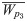
Cross Domain Diversity Weighting (Before/After).The cross domain diversity weight (DW) for the edge between predicate P3 and predicate P4 is computed as 0.35 using Eq (1). SW(P3, P4) = 0.2 and Wp3¯ = 0.2+0.5+0.83 = 0.5 and Wp3¯ = 0.2+0.2+0.33 = 0.23. DW(P3, P4) = Max(SW(P3,P4)+Wp3¯2,SW(P3,P4)+Wp4¯2) = Max(0.2+0.2+0.5+0.832,0.2+0.2+0.2+0.332) = Max(0.35,0.21) = 0.35.